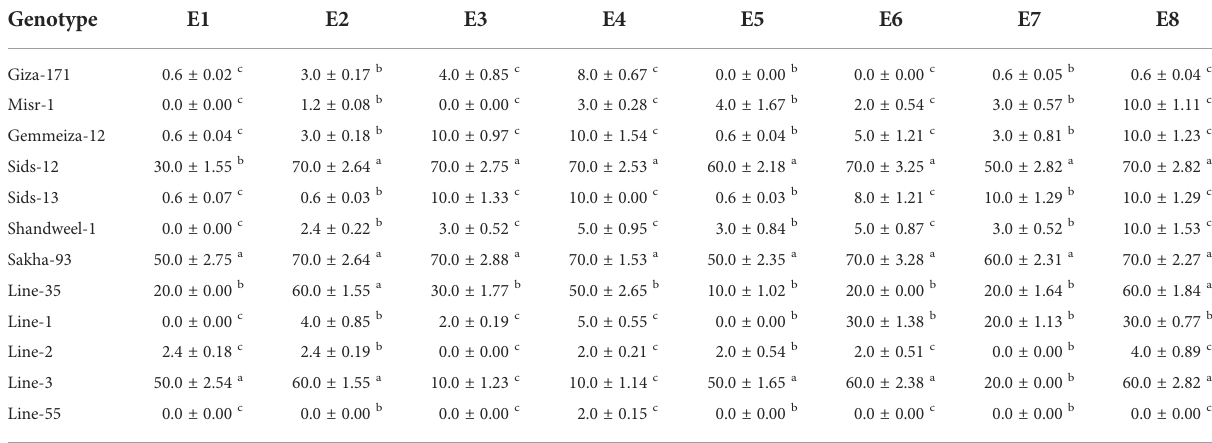
E1-E8 are the evaluated environments as presented in Table 1. The same letters under the same environment are not signi fi cantly different by the least signi fi cant difference at p ≤